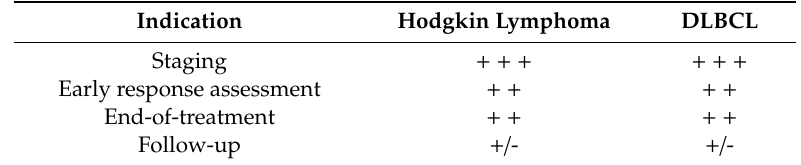
Table 3. Evidence-based recommendations on the use of FDG-PET before, during, and after treatment.